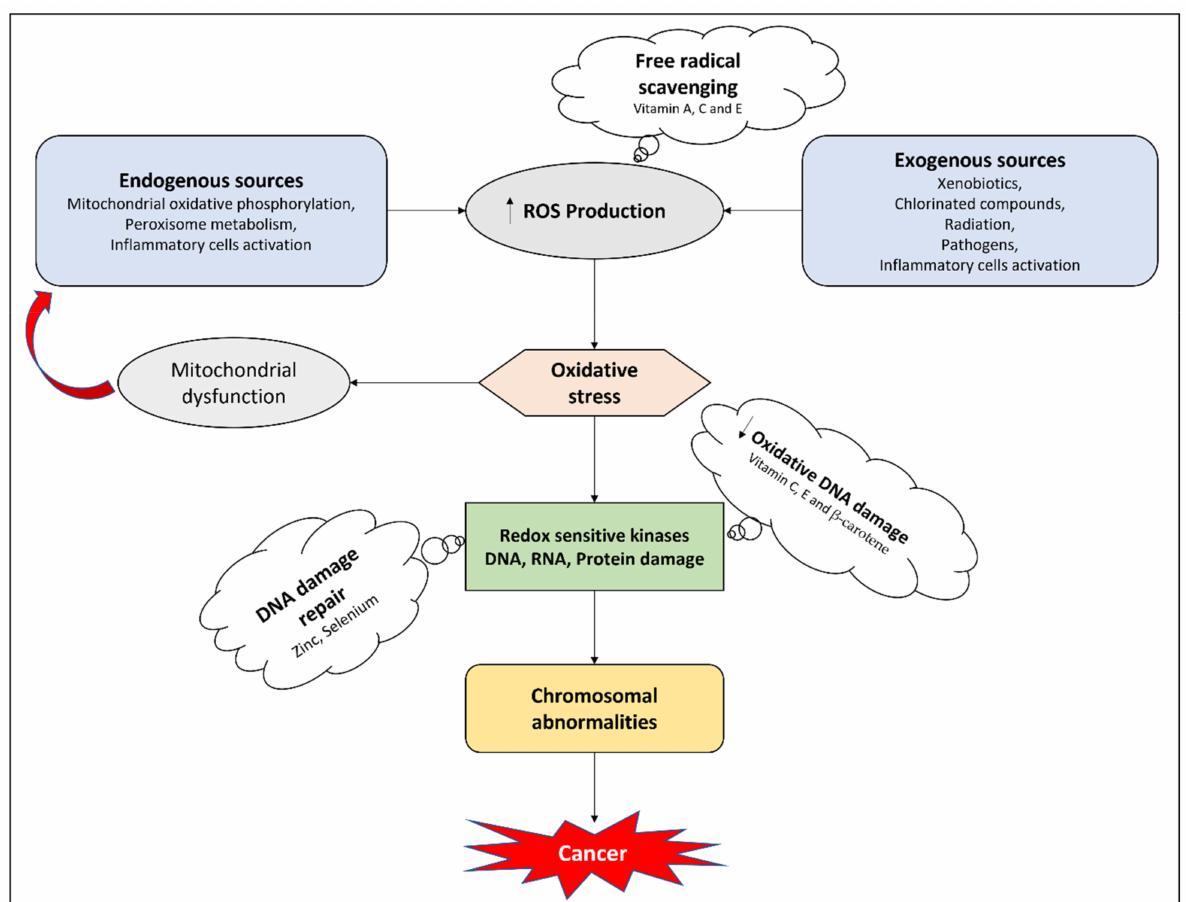
Figure 1. Potential mechanisms of micronutrients in countering oxidative stress. Increase ( ↑ ); decrease ( ↓